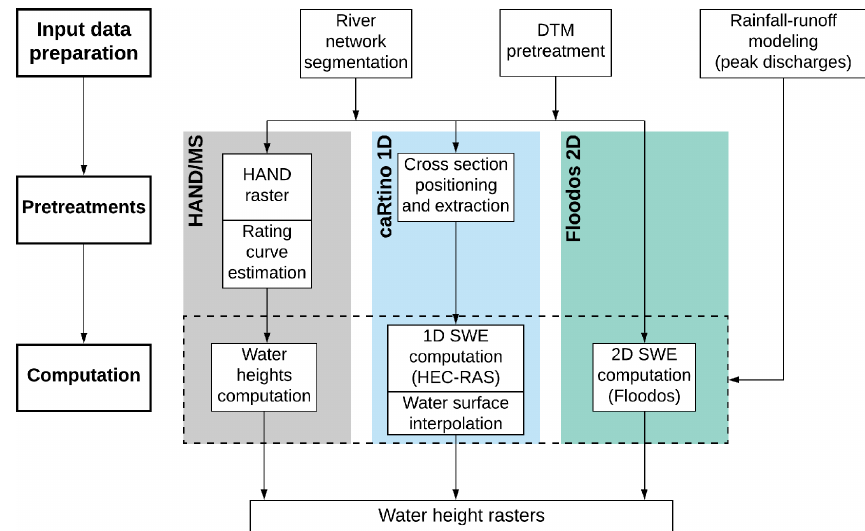
Figure 1. Synthetic representation of the simulation workflow for the three selected flood mapping